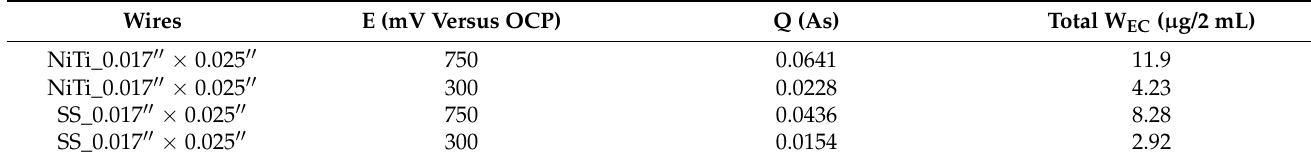
Table 7. The average expected ion release from the NiTi wires at 300 mV.